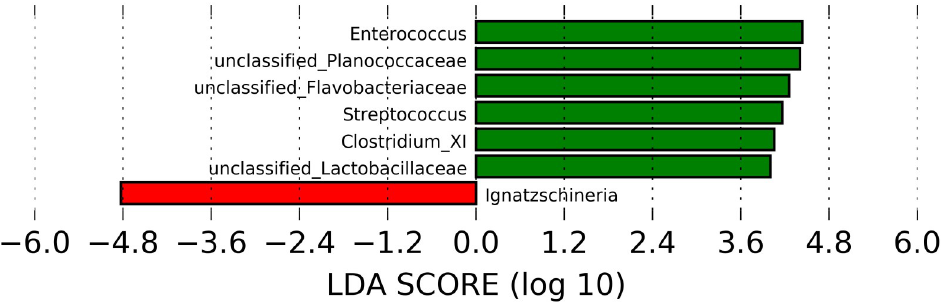
Fig 4. Linear discriminant analysis effect size (LEfSe) indicating differentially enriched fecal bacterial communities (with LDA score > 3) at the genus level of adult females by season (n = 117). Green = winter (n = 34), red = summer (n = 83). Samples were obtained from 46 and 39 farms in 2015 and 2016,